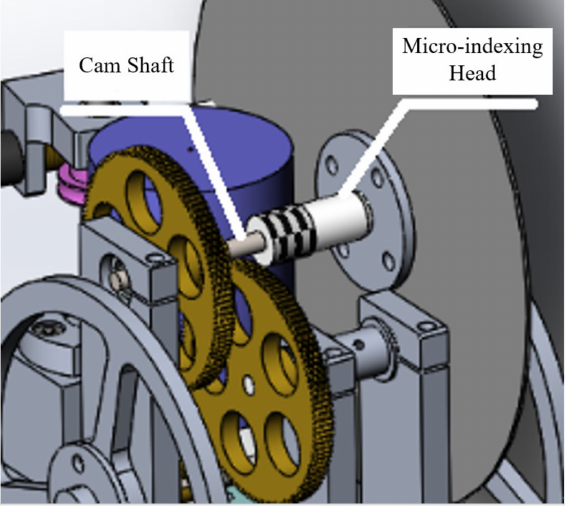
Figure 8. Micro-indexing head’s